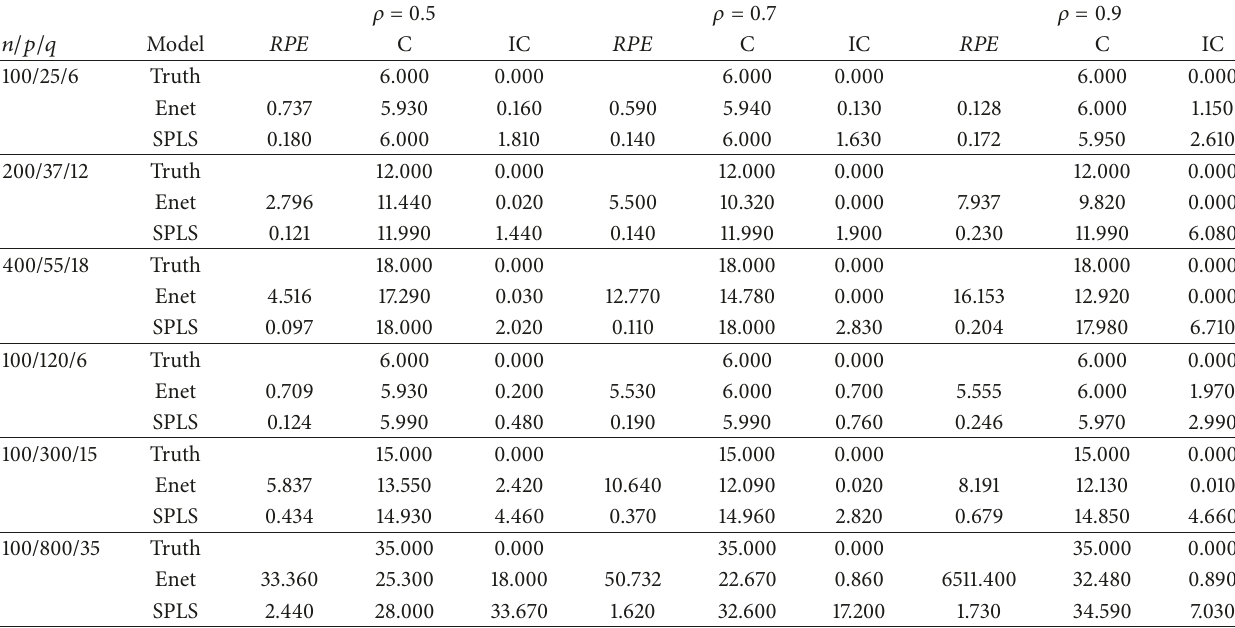
Table 1: Comparison of Enet and SPLS under combinations of different 𝑛, 𝑝,𝑞 and 𝜌 based on the 100 replications. 𝑅𝑃𝐸 is the relative prediction error, “C” and “IC” are the number of predictors that are correctly and incorrectly selected into the model, respectively. 𝜌 = 0.5 𝜌 = 0.7 𝜌 = 0.9 𝑛/𝑝/𝑞